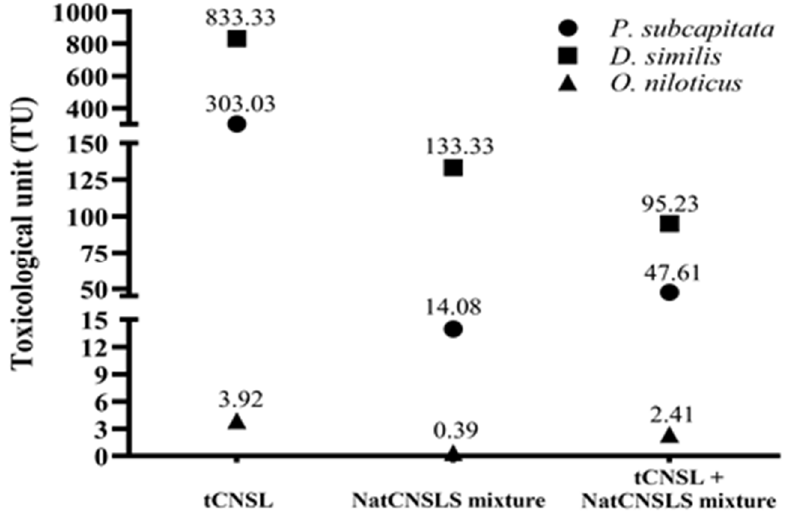
Figure 1. Comparison of the sensitivity of the test-organisms P. subcapitata, D. similis and O. niloticus . For this comparison, the acute toxicity data obtained for the three products tested were converted to toxicological units.